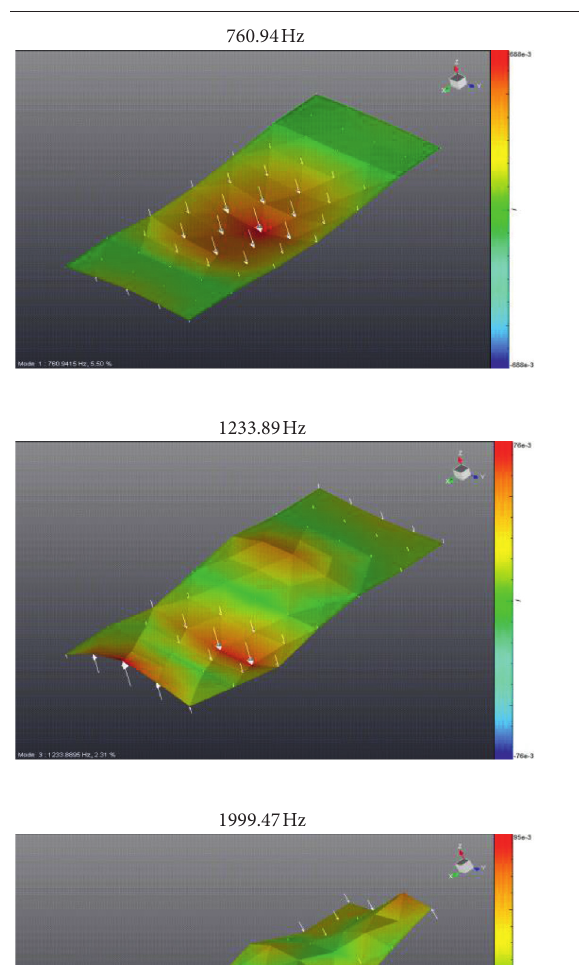
Table 13: Experimental modal analysis: mode shapes and natural frequencies (Case